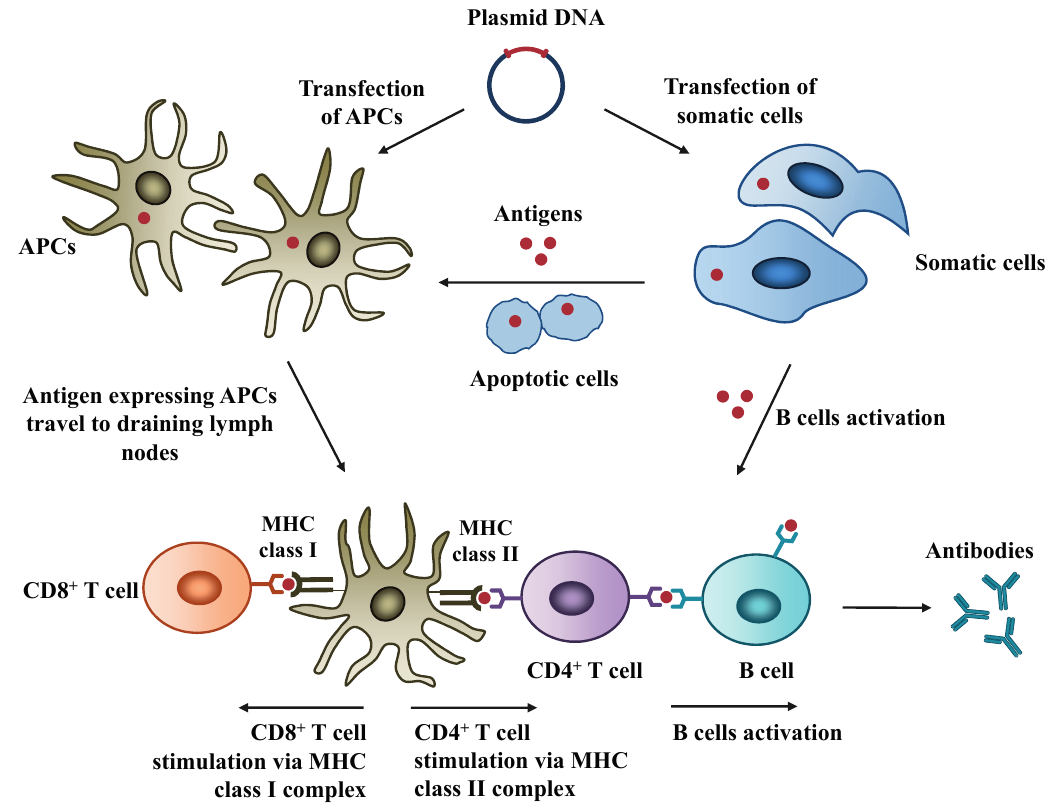
Figure 1. Mechanisms of action of DNA vaccines. Plasmid DNA encoding antigen of interest is transfected into antigen presenting cells (APCs) or somatic cells. Secreted antigens activate B cells, leading to antibodies production. APCs are activated by direct transfection or cross-presentation (indirect transfer of antigens). APCs then migrate to the draining lymph nodes where they present antigenic peptides to T cells via MHC-I and